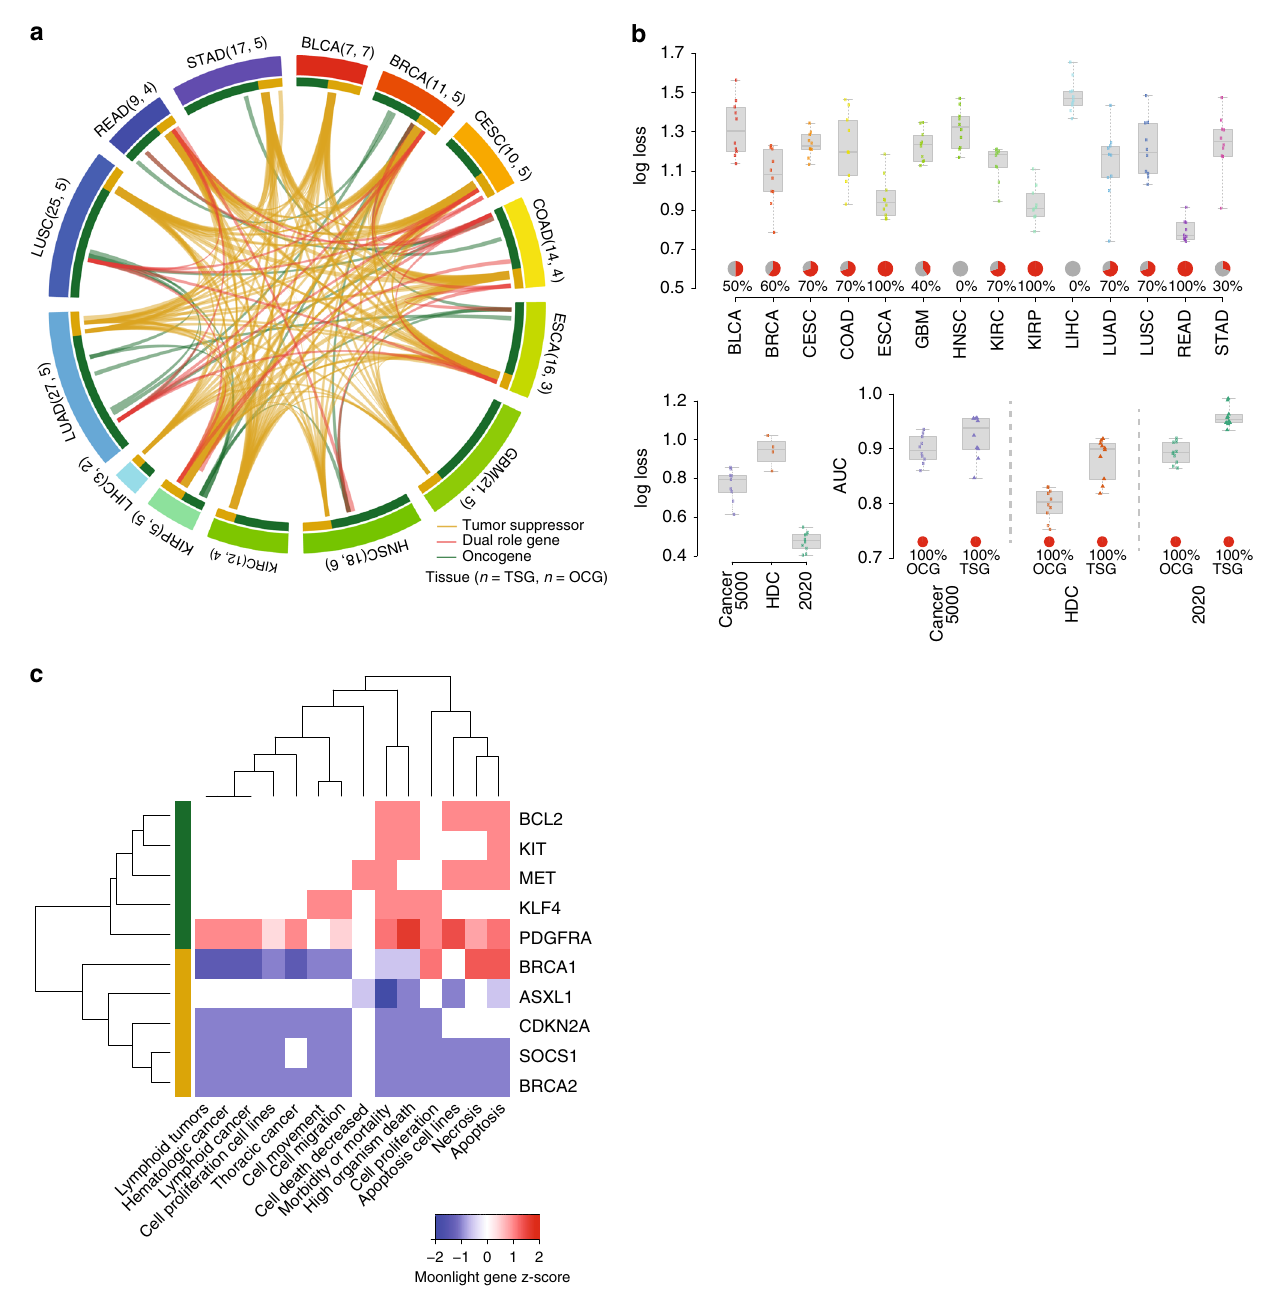
Fig. 6 Moonlight a Pan-Cancer study: dual-role genes and machine-learning approach. a Circos plot showing an integrative analysis of 14 TCGA cancer types using the ML approach. Labels around the plot specify the cancer type; the number of OCGs and TSGs for that cancer type are in parentheses. An edge is drawn in the center of the fi gure whenever the same gene is predicted in two different cancer types. Segments and edge colors correspond to cancer type: green (yellow) segments correspond to the number of OCGs (TSGs) predicted in that cancer type, and red edges represent dual-role genes. b Performance evaluation of Moonlight in terms of log loss for tumor suppressors and oncogenes predicted in 14 cancer types. Performance of 20/20 + and OncodriveRole in terms of log loss and AUC. c Heatmap showing Moonlight Gene Z-score for upstream regulators for rectum adenocarcinomas. Row colors indicate TSGs (yellow) and OCGs